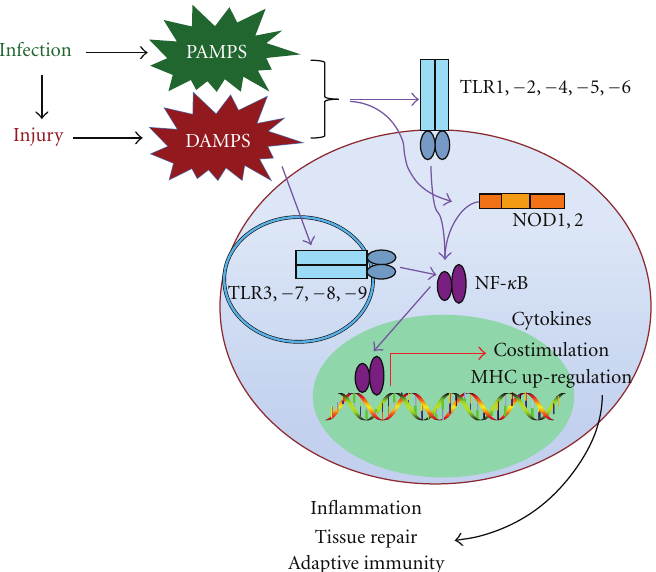
Figure 1: Infection and cell injury result in the production of PAMPs and DAMPs that promote the inflammatory response via TLRs located on the cell membrane and within endosomes. Cytoplasmic PAMPs activate similar pathways by binding to NOD1 and